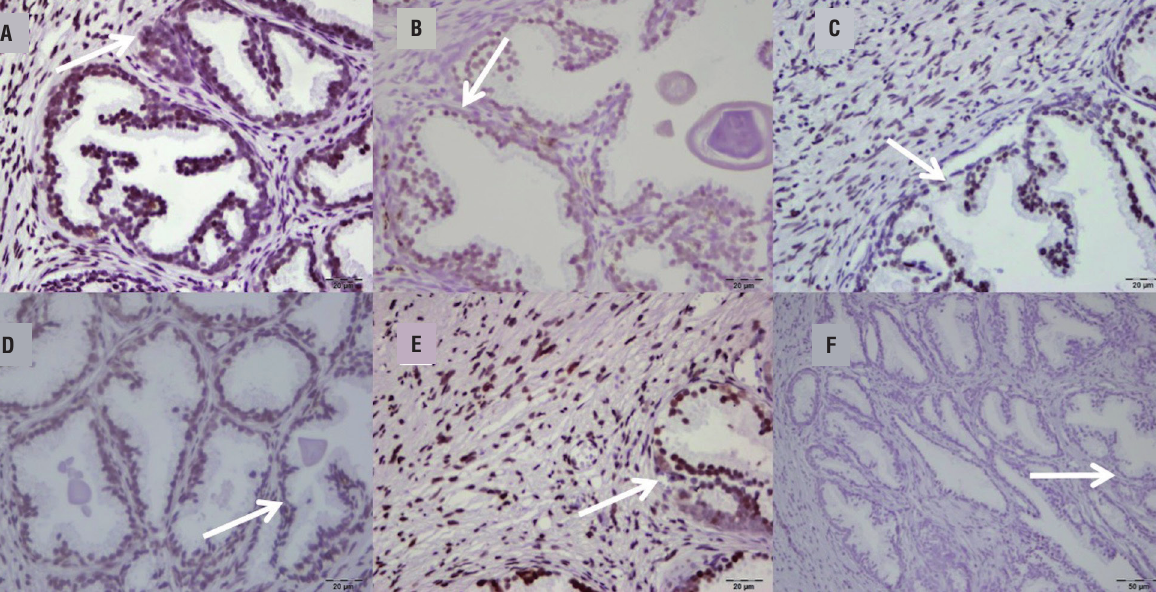
Scale bars=20μm for A-E. Scale bars=50μm for